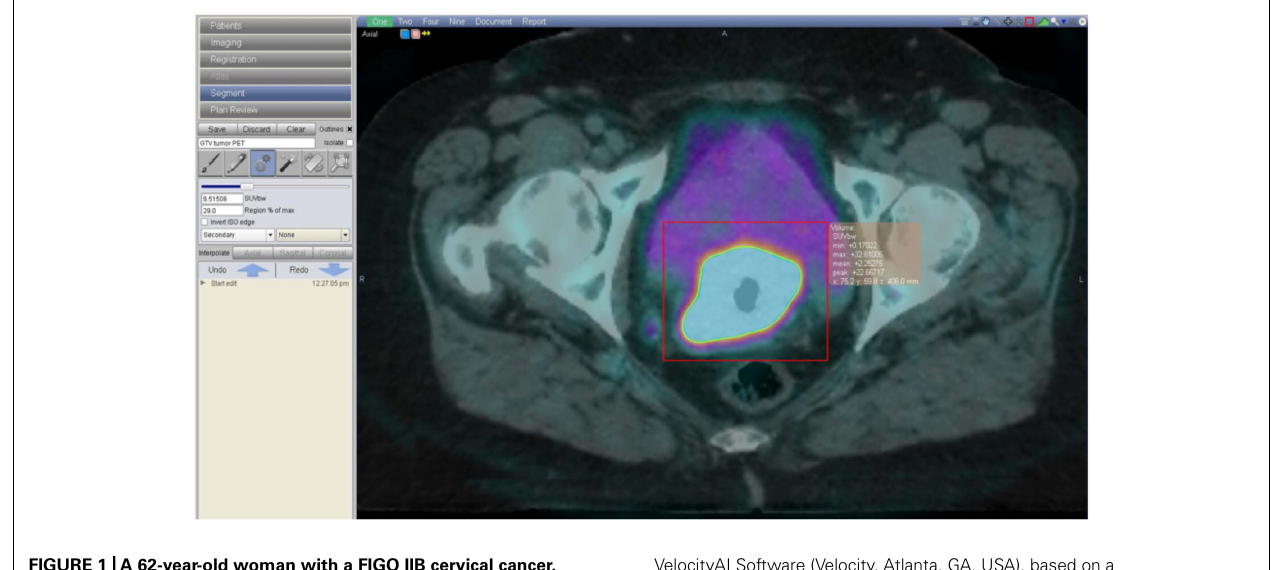
VelocityAI Software (Velocity, Atlanta, GA, USA), based on a method of automatic 3D volume segmentation of the functional image, that depends on the relationship between source to background ratio.